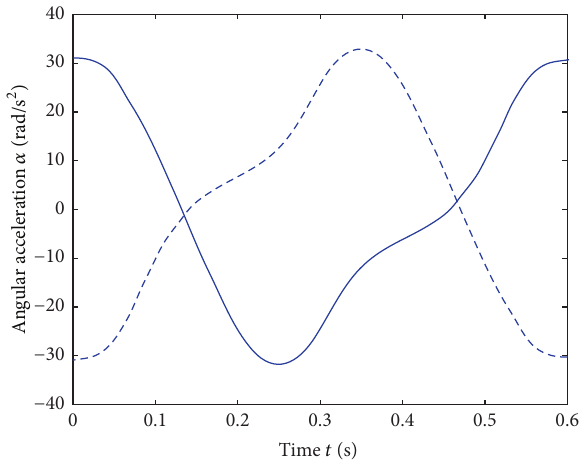
Figure 1: The dual-elbow-bar driving mechanism of die-cutting machine. Figure 2: The angular acceleration of BC and B 󸀠 C 󸀠